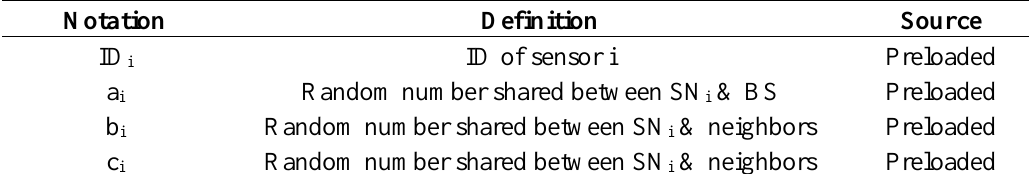
Table 2. Reference of important parameters and terms used by